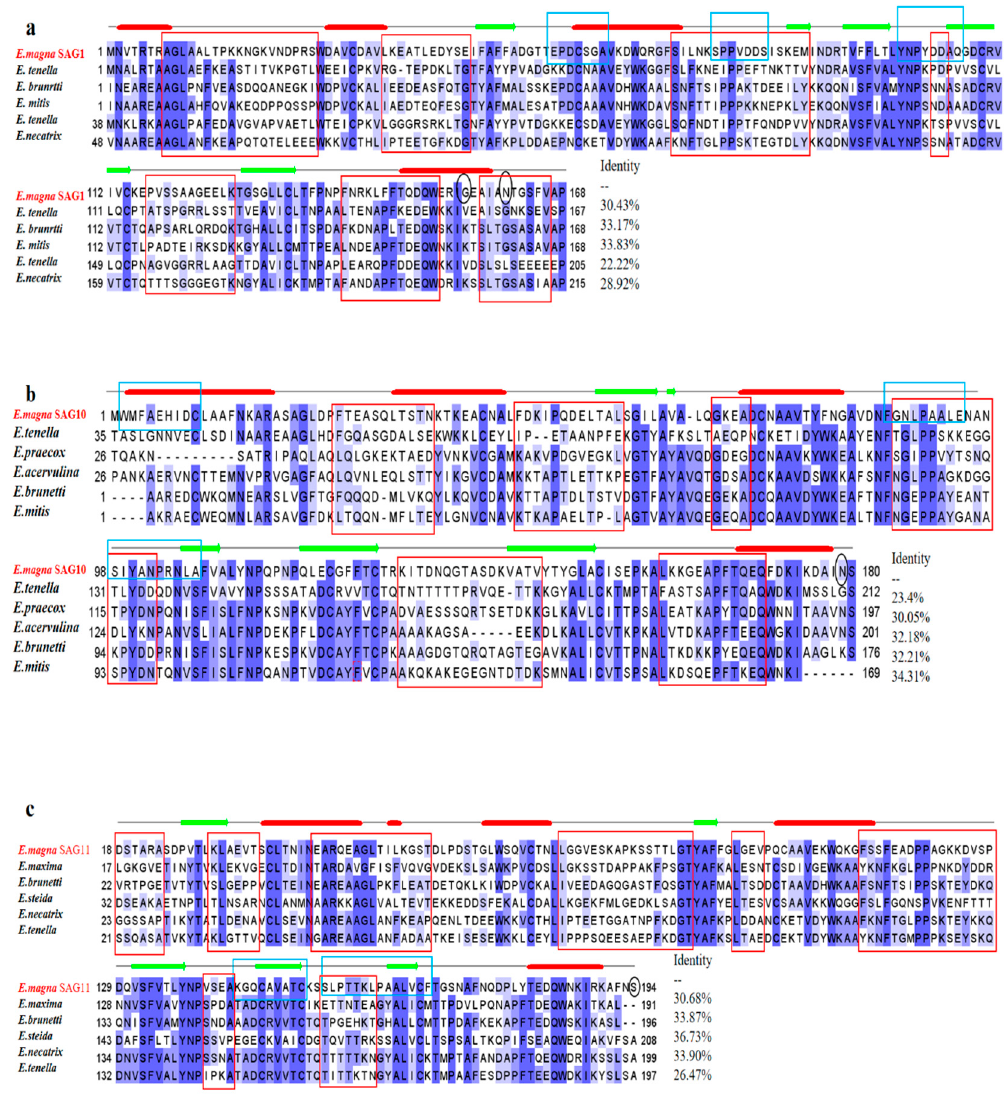
Figure 1. Multiple sequence alignments of SAG1 ( a ), SAG10 ( b ), and SAG11 ( c ) from different Eimeria . ( a ) Multiple alignment of E. magna SAG1 with SAG proteins from its Eimeria : Eimeria tenella (UniProt: XP_013232730), Eimeria brunetti (UniProt: CDJ45679.1), Eimeria mitis (UniProt: XP_037878758.1), Eimeria tenella (UniProt: CAE52292.2), Eimeria necatrix (UniProt: XP_013439715.1); ( b ) Multiple alignment of E. magna SAG10 with its SAG protein from Eimeria : Eimeria tenella (UniProt: CAE52313.1), Eimeria praecox (UniProt: CDI74849.1), Eimeria acervulina (UniProt: XP_013251483.1), Eimeria brunetti (UniProt: CDJ51402.1), Eimeria mitis (UniProt: XP_013355552.1); ( c ) E. magna Multiple alignment of SAG11 with SAG proteins from its Eimeria : Eimeria maxima (UniProt: XP_013334600.1), Eimeria brunetti (UniProt: CDJ45678.1), Eimeria stiedai (GenBank accession number: QIS60152.1), Eimeria necatrix (UniProt: XP_013439715.1), Eimeria tenella (UniProt: CAE52299.1). Blue shading indicates the conserved residues. Red boxes represent B-cell epitopes. Blue boxes indicate T-cell epitopes of E. magna SAGs. Black circles indicate GPI anchor points.